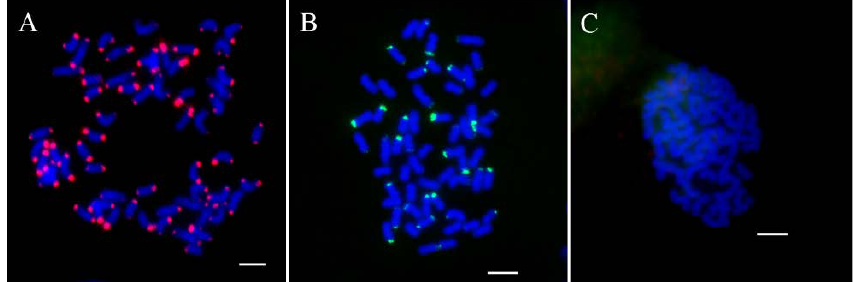
Figure 2. The signal expression to the different copied probes. ( A ): Two ends of chromosomes; ( B ): The end of a part of chromosomes; ( C ): No obvious signal. Scale bars = 5 μm.